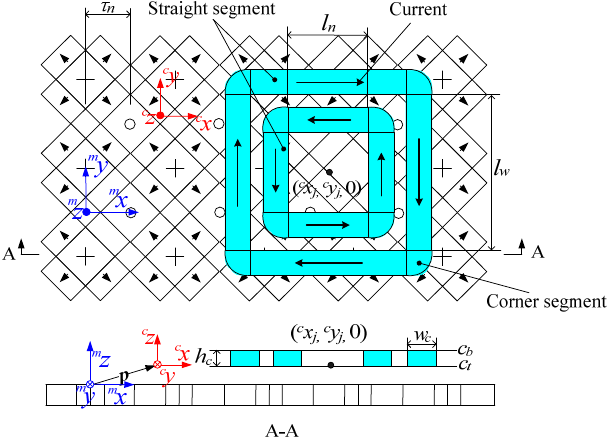
Figure 2. Top views and A-A view of the components of a maglev planar motor: a Halbach array and a concentric structure winding.